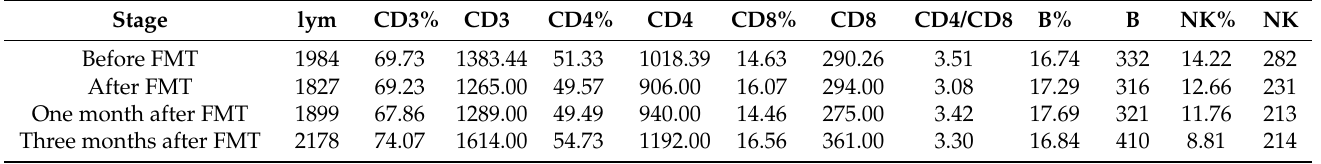
Table 2. Immune cell changes before and after FMT.